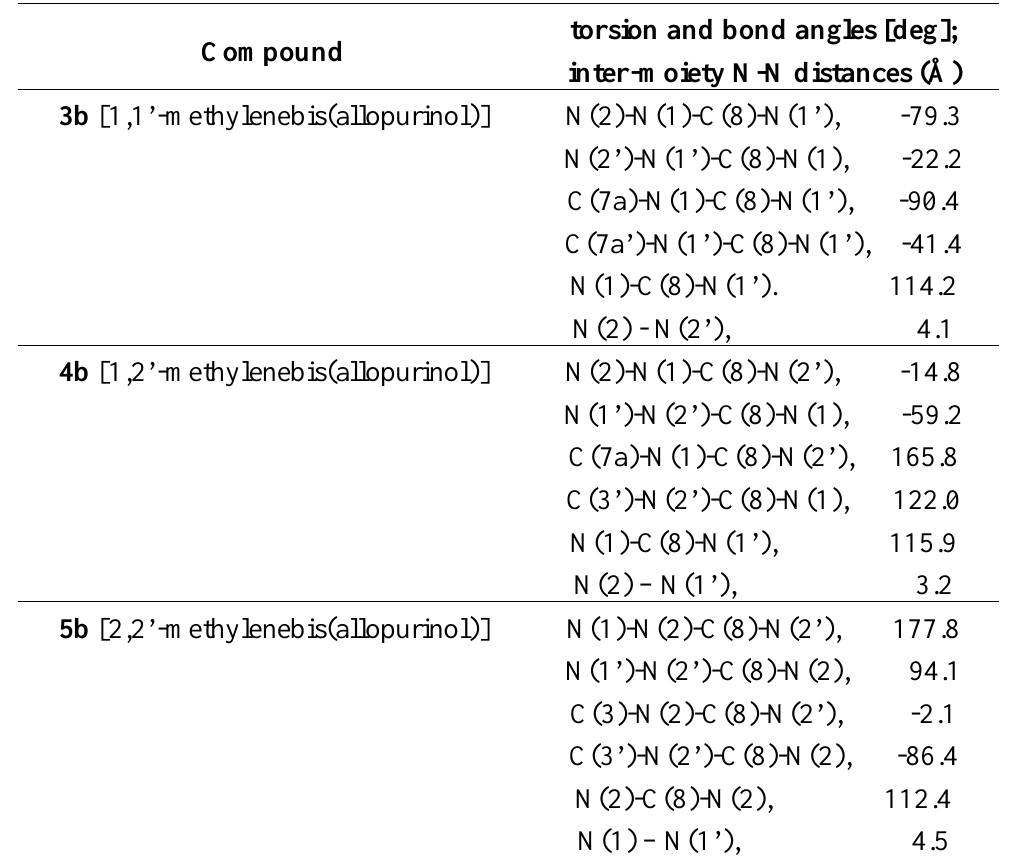
Table 3 . Selected torsion and bond angles as well as inter-moiety N-N distances (Å) of compounds 3b –